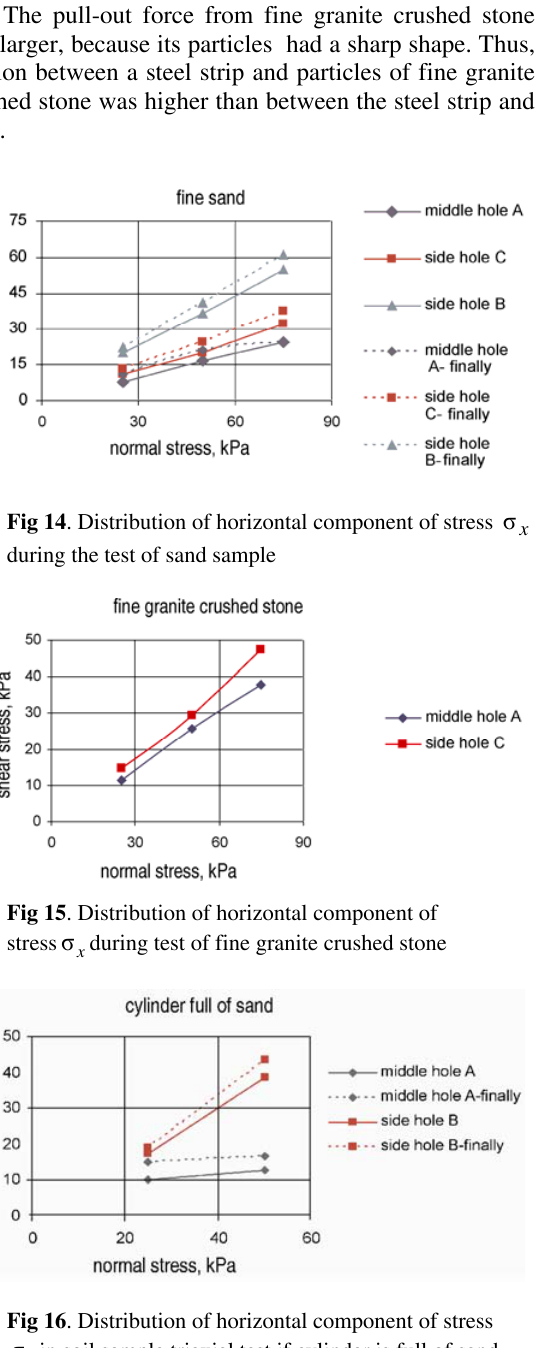
Fig 16 . Distribution of horizontal component of stress σ in soil sample triaxial test if cylinder is full of sand x